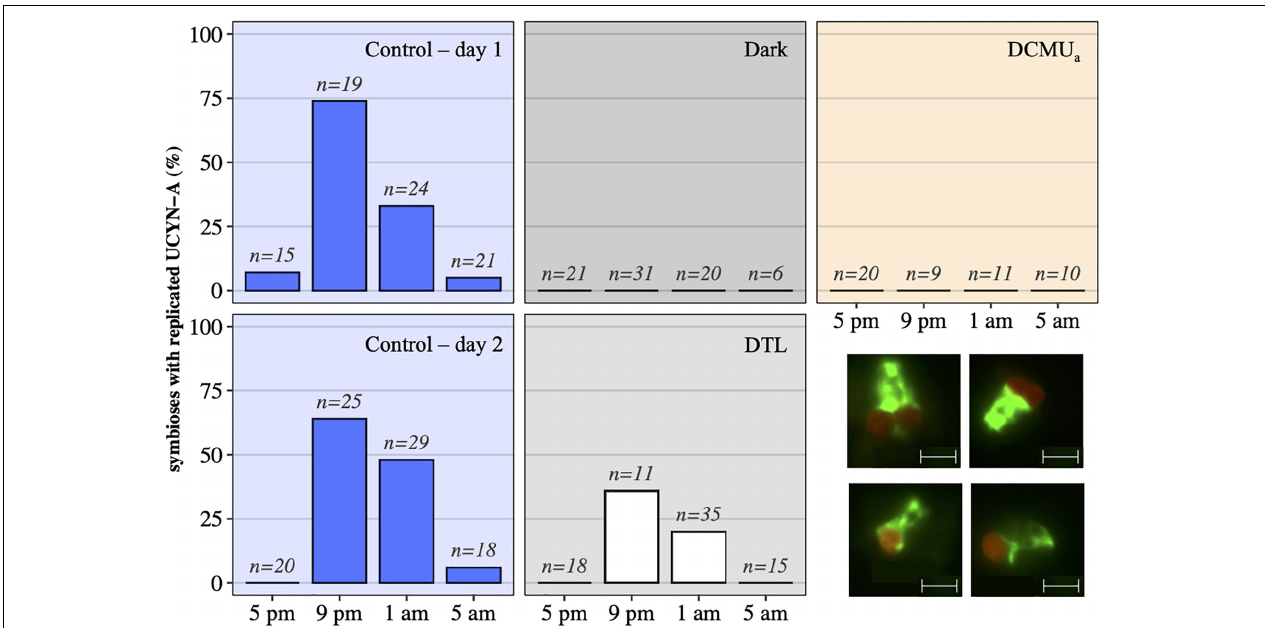
FIGURE 3 | UCYN-A2 replication and division patterns in control (blue – day 1, top and day 2, bottom), dark (black), DCMU a (orange), and DTL (white) experimental conditions, as determined by epifluorescence microscopy. For each time point and condition, n represents the number of individual symbioses analyzed. Bottom right: examples of epifluorescence microscopy images showing individual symbioses where the host (green) is associated with a replicated symbiont (red) as seen in samples collected at 9 p.m. in the control (top row), or symbioses with a unique symbiont as seen in samples collected at 9 p.m. in the dark (bottom row). The scale indicates 5 µ